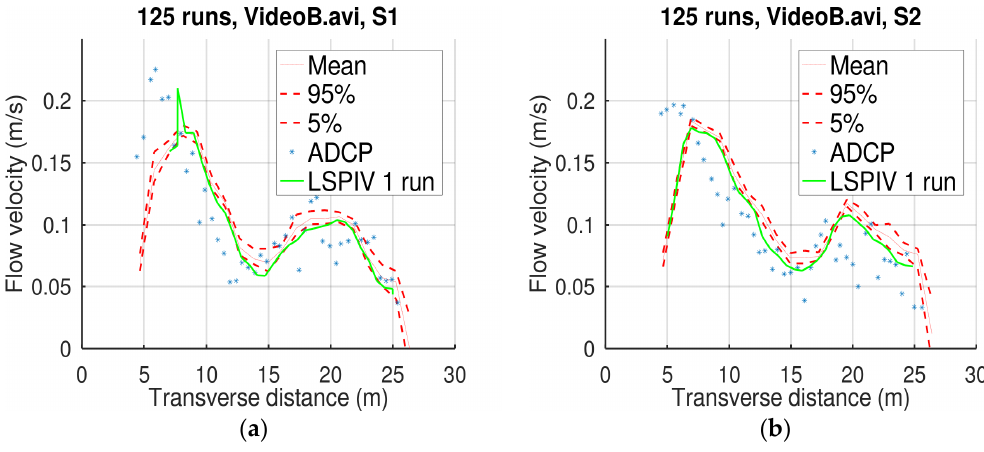
Figure 8. Velocity profiles and measurements for Video B and the cross-sections S1 ( a ) and S2 ( b ).